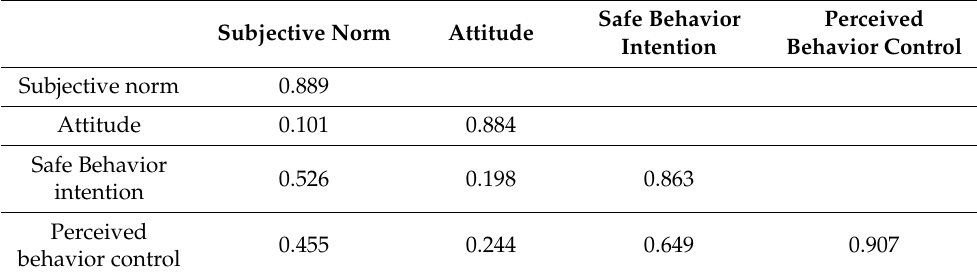
Table 2. Analysis of discriminant validity (Fornell–Larcker